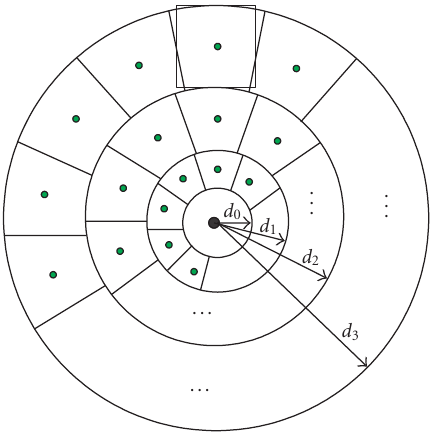
Figure 6: A coalition-based multihop